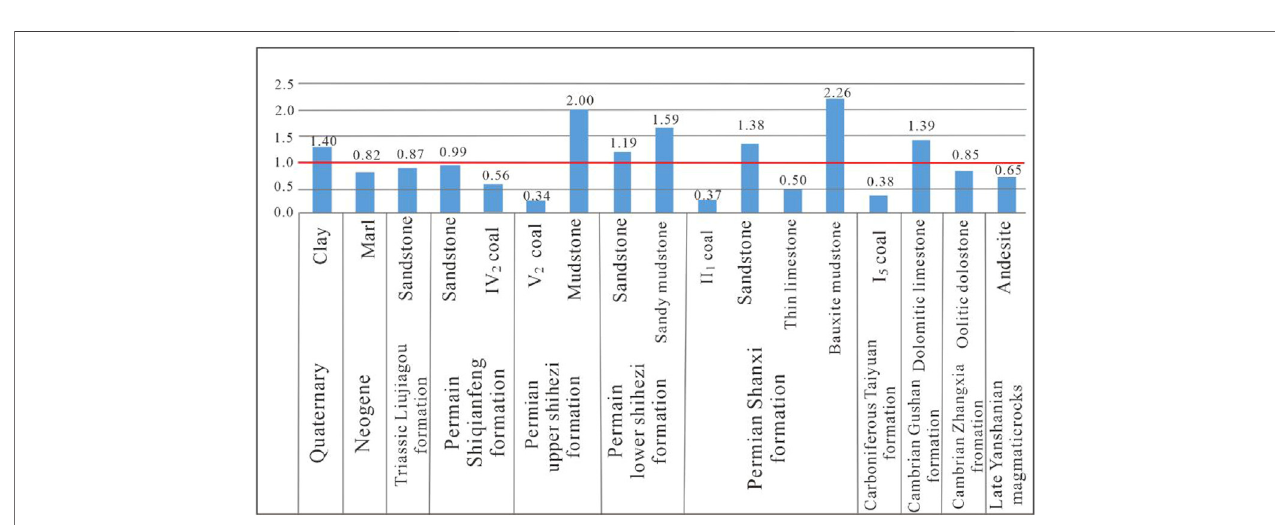
FIGURE 7 | Rate of radiogenic heat generation in the different strata ( μ W/m 3